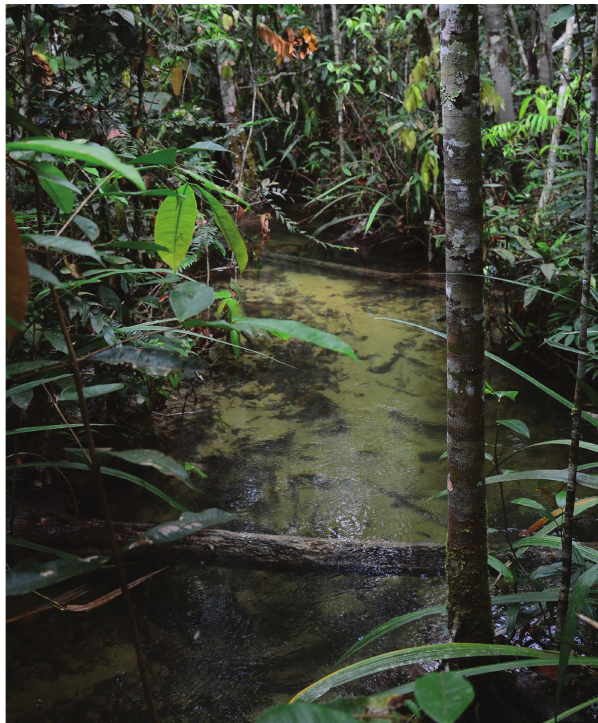
Fig. 4. Tributary of igarapé Piracolina, upper rio Machado, Vilhena, Rondônia, Brazil, type locality of Moenkhausia